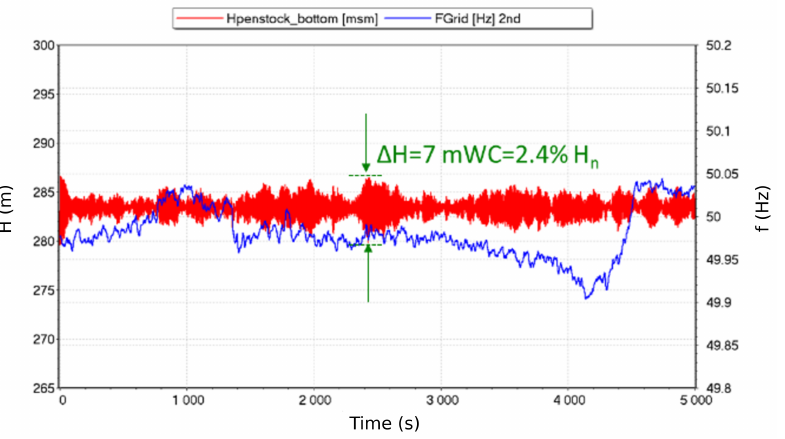
Figure 9. Simulation of the pressure fluctuations at the penstock bottom ( Hpenstock _ bottom ) gener- ated by the grid frequency